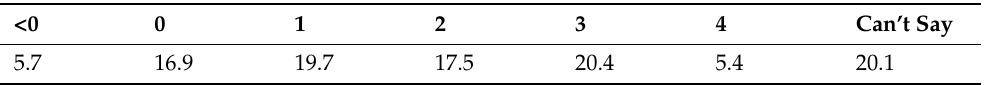
Table 7. Predicted change between estimated attendance at peak lockdown and estimated attendance after programme vaccination has been completed (n =